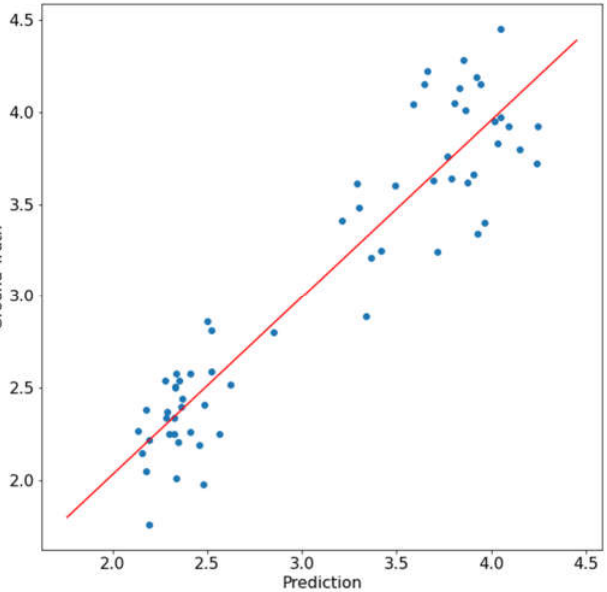
Figure 8. Correlation between N prediction and ground truth data using the NDVI heatmap distribution modeling.